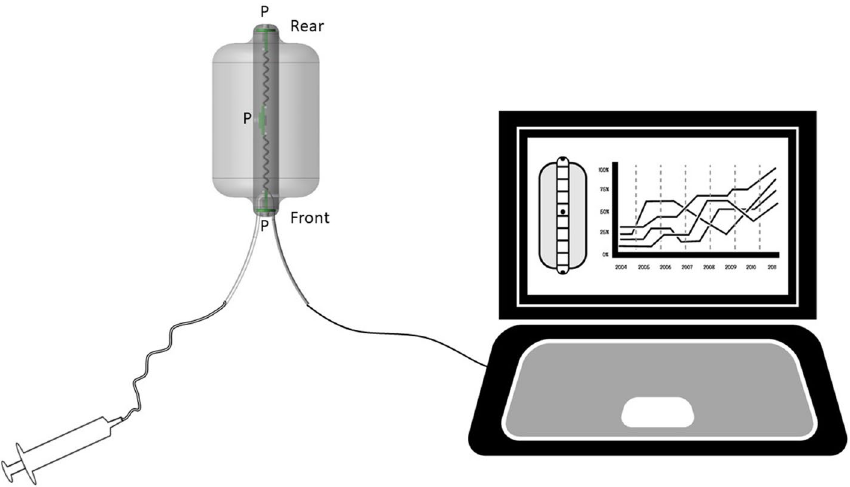
Figure 2. Schematic of the system with the wired Fecobionics device and the data collection device including monitor. The soft resin core of Fecobionics contains the central processing unit and three pressure sensors placed at the front, rear and inside the bag. Furthermore, it contains two Motion Processor Units for determination of bending (not used in this study). Wires and a filling tube is attached at the front. P = pressure